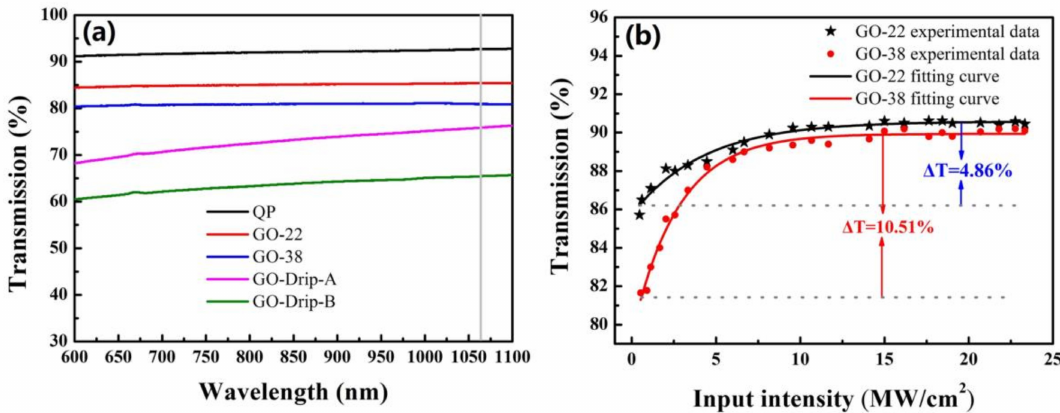
Figure 6. ( a ) Linear transmission spectra and ( b ) nonlinear optical absorption of GO-22 SA and GO-38 SA, QP refers to quartz plate.